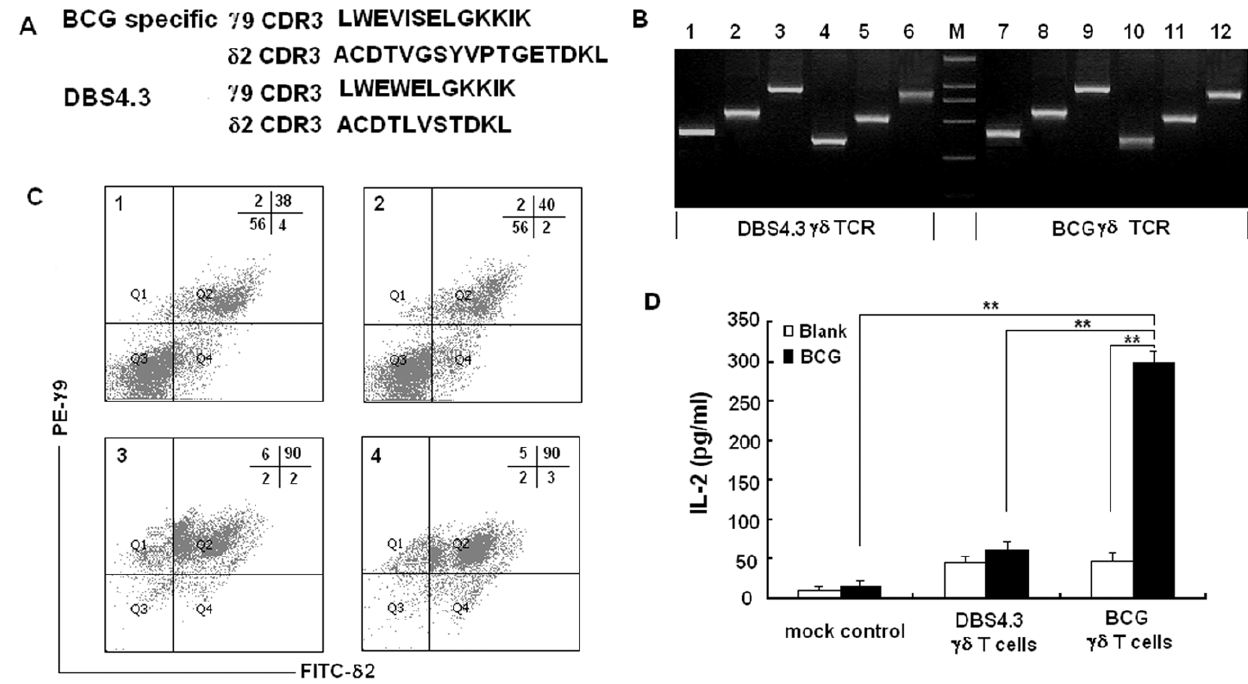
Figure 1. Construction of the transfected cells expressing BCG specific cd TCR and DBS 4.3 cd TCR. (A) The prominent c 9 and d 2 CDR3 sequence of BCG specific cd TCR and DBS4.3 cd TCR in human. (B) Construction of full-length c 9 and d 2 chain with BCG specific CDR3 sequence and DBS4.3 cd TCR by overlapping PCR. Lane 1 and lane 7. The PCR product amplified by using c 9 upstream primer and overlapping reverse primer; Lane 2 and lane 8. The PCR product amplified by using overlapping forward primer and c 9 downstream primer; Lane 3 and lane 9. The full-length c 9 chain containing prominent BCG specific CDR3 sequence or DBS4.3 CDR3 sequence amplified by using above PCR products as the template and c 9 upstream and downstream primer as the primers; Lane 4 and lane 10. The PCR product amplified by using d 2 upstream primer and overlapping reverse primer; Lane 5 and lane 11. The PCR product amplified by using overlapping forward primer and d 2 downstream primer; Lane 6 and lane 12. The full-length of d 2 chain with prominent BCG specific CDR3 sequence or DBS4.3 CDR3 sequence amplified by using above PCR products as the template and d 2 upstream and downstream primer as the primers. (C) Assessment of cd TCR expressed on J.RT3-T3.5 transfected cells via FACS analysis. Cells were stained with PE-anti c 9 monoclonal antibody and FITC-anti d 2 TCR monoclonal antibody. Panel 1 and panel 3 were the transfected cells expressing BCG specific cd TCR before and after flow sorting, respectively. Panel 2 and panel 4 were the transfected cells expressing DBS4.3 c d. TCR before and after flow sorting, respectively. (D) IL-2 secretion of the BCG specific cd TCR and DBS 4.3 cd TCR stimulated with whole protein extracts of BCG were measured by ELISA. The double asterisks denote significant difference (p , 0.01). Data are shown as the mean of pg/ml 6 S. D. of three independent cd T cells in PBMC from human subjects un-inoculated with BCG (Figure 4B). The proliferation of cd T cells expanded by BP3 peptide was further confirmed by the CCK-8 assay (Figure 4C).